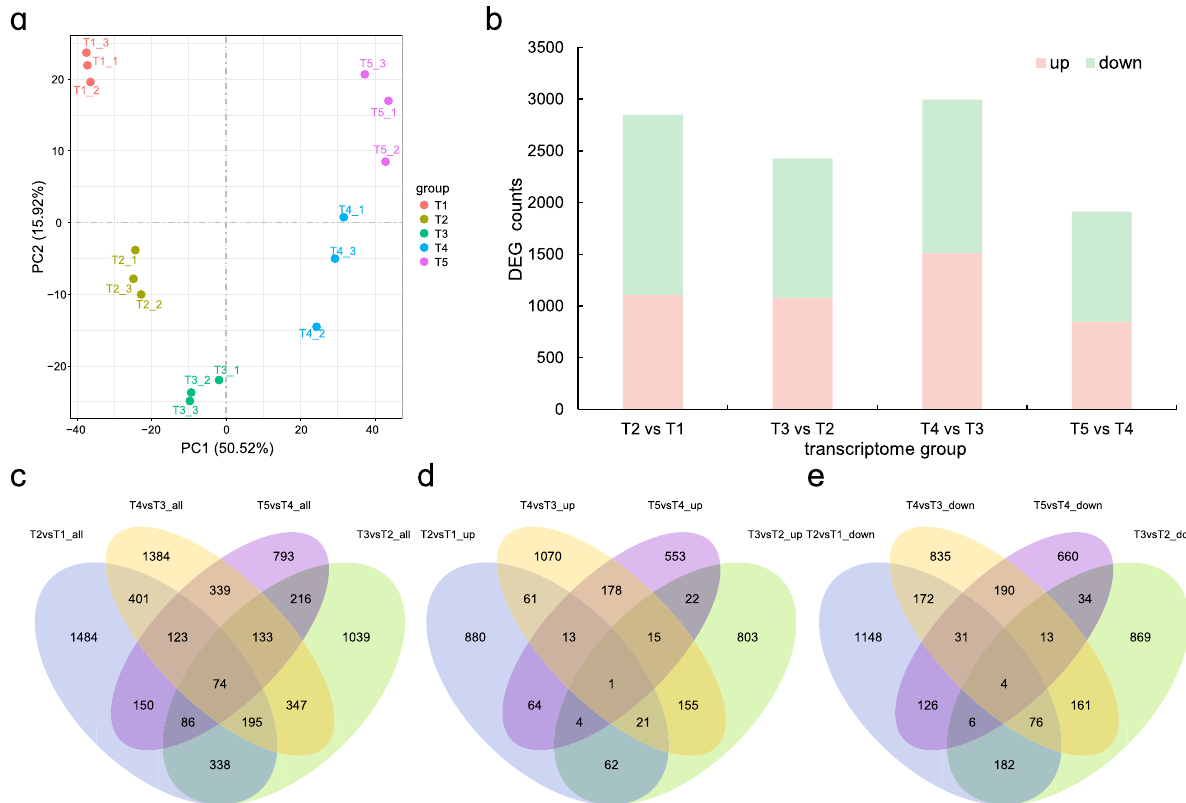
Figure 2. Overview of the C-PCNA Persimmon Developing Fruit transcriptome. ( a ) Principal component analysis. ( b ) Summary of DEGs in all combinations of developmental stage comparisons. The number of total DEGs ( c ), upregulated DEGs ( d ), and downregulated DEGs ( e ) are presented by Venn diagrams (|log2-fold change|> 1 and padj <